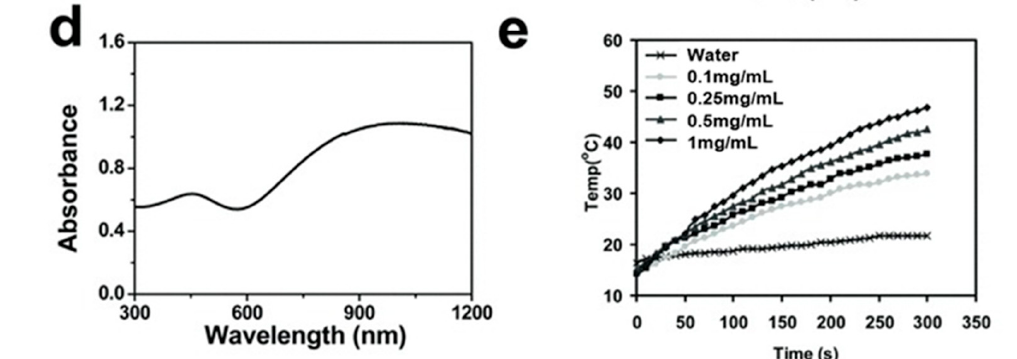
Figure 6. ( a ) Schematic representation of synthesis of poly(vinyl alcohol) (PVA). ( b ) Transmission electron microscopy (TEM) image of PPy NPs. ( c ) Dynamic light scattering (DLS) data of PPy NPs. ( d ) UV-Vis-NIR absorbance spectrum of a PPy solution (inset: photo of PPy solutions in water, saline, and fetal bovine serum). ( e ) Heating curves of water and various PPy concentration (0.1, 0.25, 0.5, and 1 mg / mL), 808 nm laser irradiation, and power density of 0.5 W / cm 2 . PPy: polypyrrole; NPs: nanoparticles. Reproduced with permission from Yang, K.; Xu, H.; Cheng, L.; Sun, C.; Wang, J.; Liu, Z. In vitro